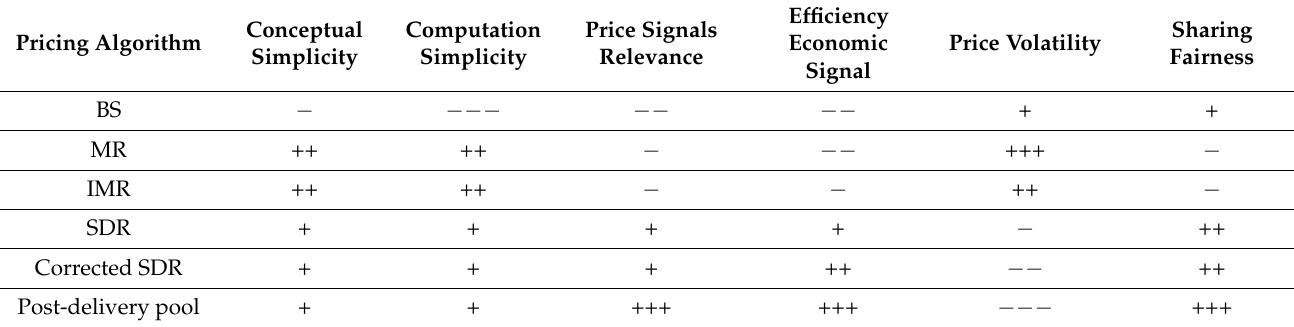
Table 1. Qualitative comparison of pricing